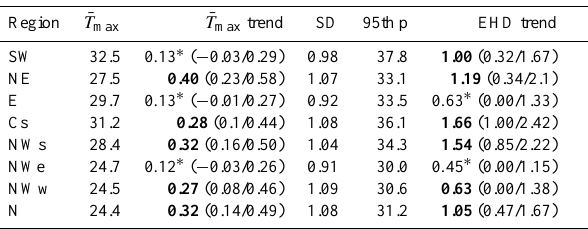
Table 1. Statistics summarizing the eight regional series. The sec- ond and third columns show the mean and trend ( ◦ Cdecade − 1 ) of the daily maximum temperature series. The standard deviation of the de-trended series is shown in the fourth column. The fifth col- umn exhibits the 95th percentile. Finally, the sixth column shows the EHD trends (days/decade). Bold values (asterisks) indicate sig- nificant values at 95% (90%) confidence level (estimated with the Mann–Kendall test). Values are obtained for the period 1951–2008, but for EHD trends the 1958–2008 period is considered. Confidence intervals (95% of significance) for Sen’s trends are indicated in parentheses for T x and EHD